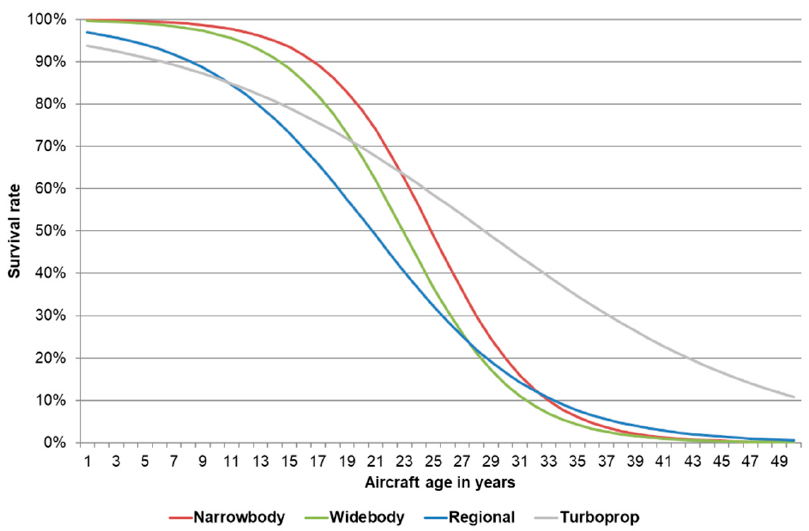
Figure 8. Seat load factor data and forecast [27,48,49].